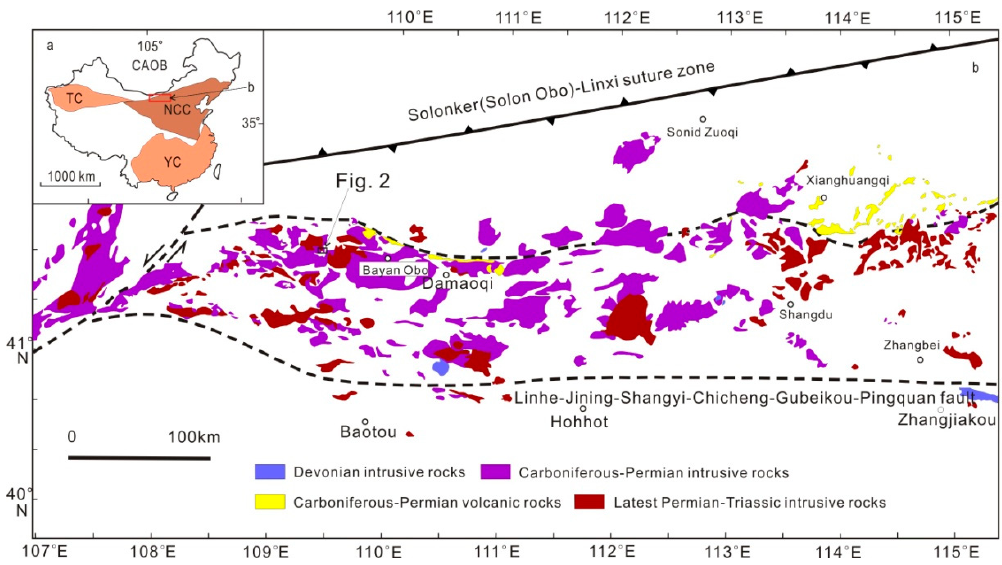
Figure 1. (a) Tectonic framework of China, showing the location of (b) Distribution of Paleozoic magmatic rocks along the northern margin of the North China Craton (NCC) (modified after [6]). TC, Tarim Craton; YC, Yangtze Craton.